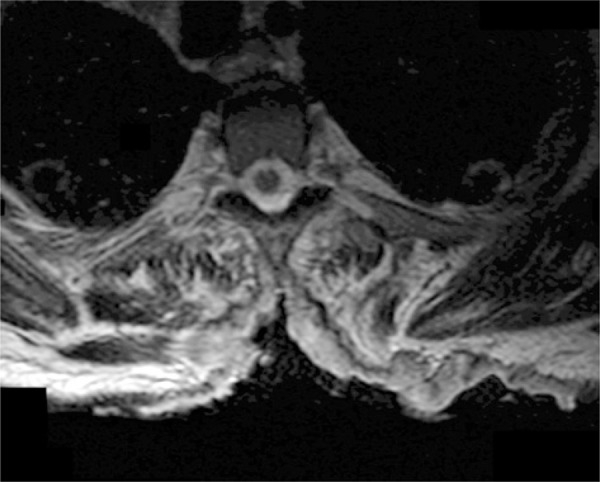
Visão axial de espinha em T5, por meio de ressonância magnética, demostrando ausência de envolvimento do cordão espinhal